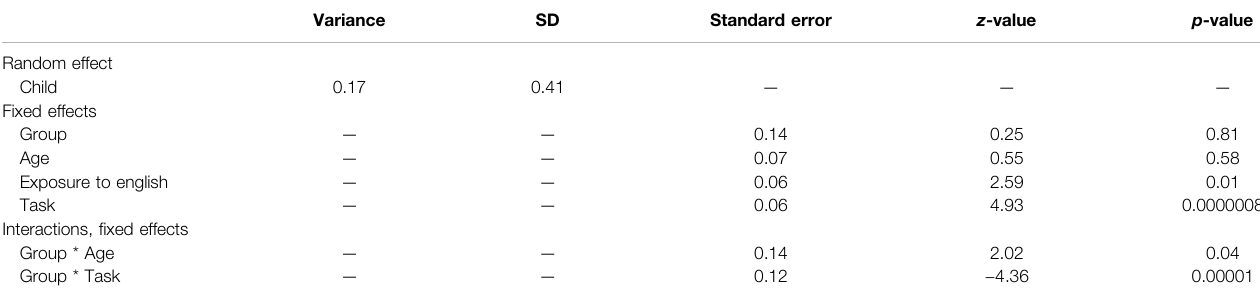
TABLE 7 | Logistic regression results examining individual differences in complex syntax use with the full sample combined and where the outcome variable was a binary variable (simple or complex sentence).